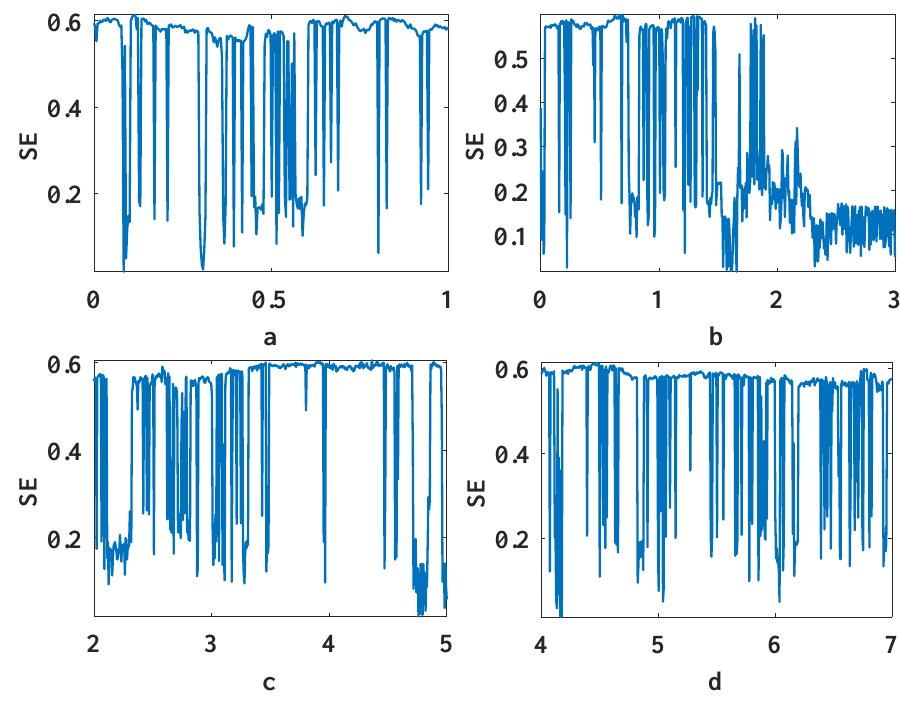
Figure 3. The SE of the fractional memristive system versus